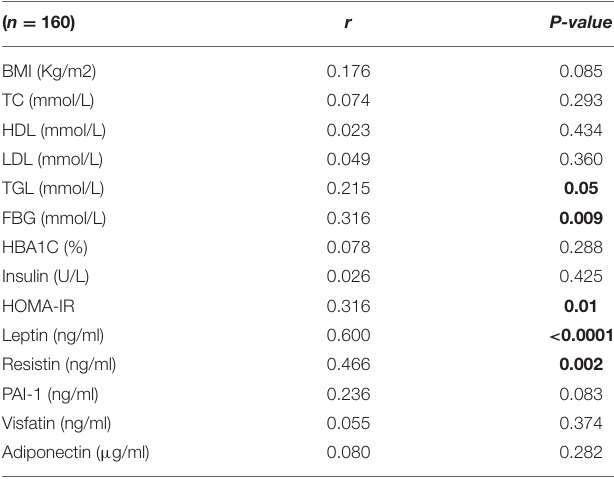
TABLE 3 | Correlation between circulating DNAJC27 protein and physical, clinical, and biochemical parameters in the non-diabetic population adjusted for age. ( n =